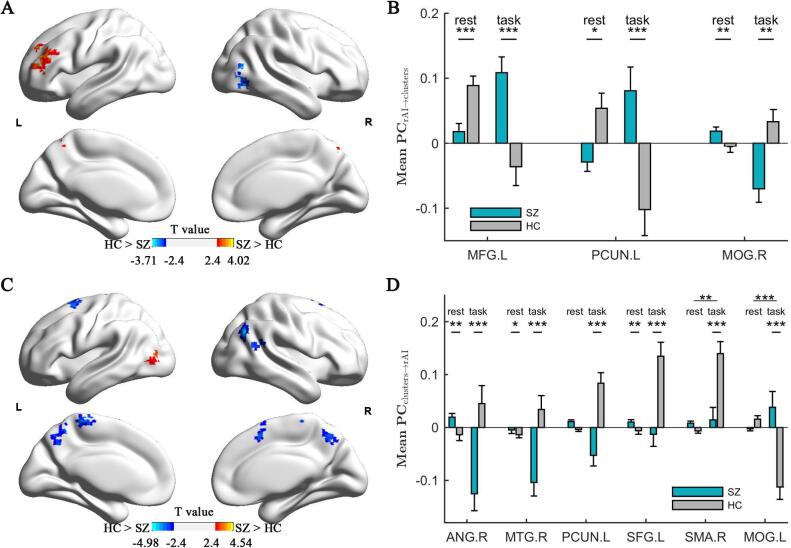
Group difference in the change of rAI-Brain interaction when shifting from rest-to-task between patients and controls. Change of path coefficient (CPC) at the identified clusters from rAI to whole brain (A) and from whole brain to rAI (C); Mean path coefficient (PC) of each cluster from rAI to whole brain (B) and from whole brain to rAI (D) (*p < 0.05, **p < 0.005, ***p < 0.0005).